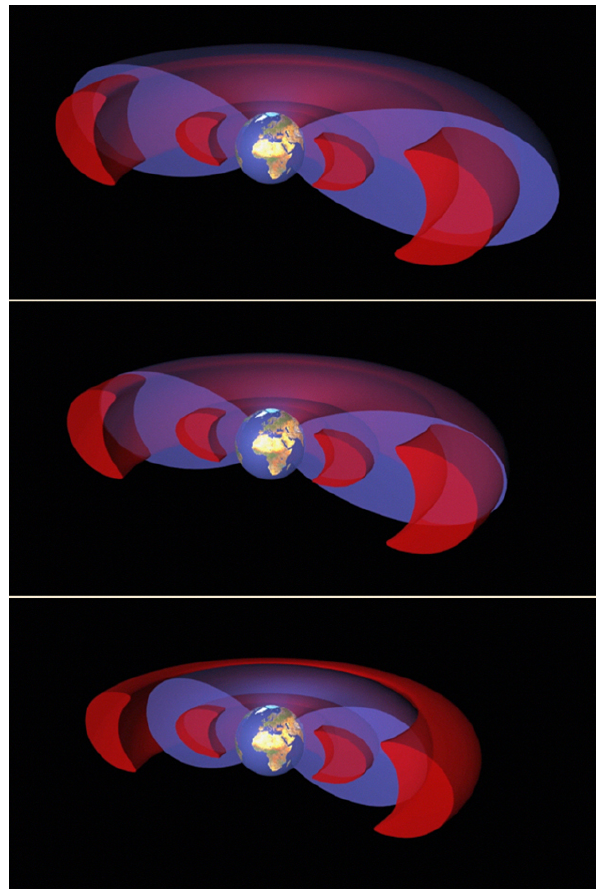
Figure 9. These three panels sketch how the relative locations of the outer boundary of the Earth’s plasmasphere, the plasmapause (shown in blue) and the van Allen belts (shown in red) change ac- cording to geomagnetic conditions (geomagnetic activity increases from top to bottom). The proton belt is the inner red belt and the electron belt is the outer one.